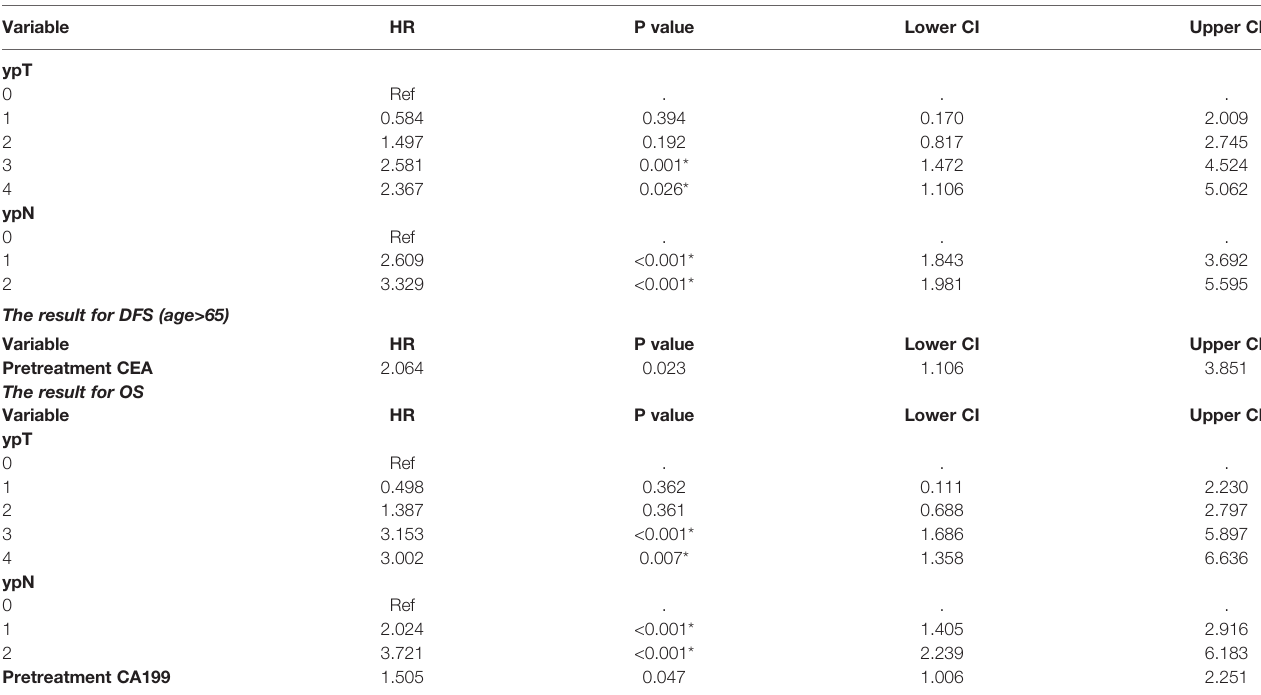
TABLE 3 | Stepwise multivariate Cox analysis for DFS and OS.